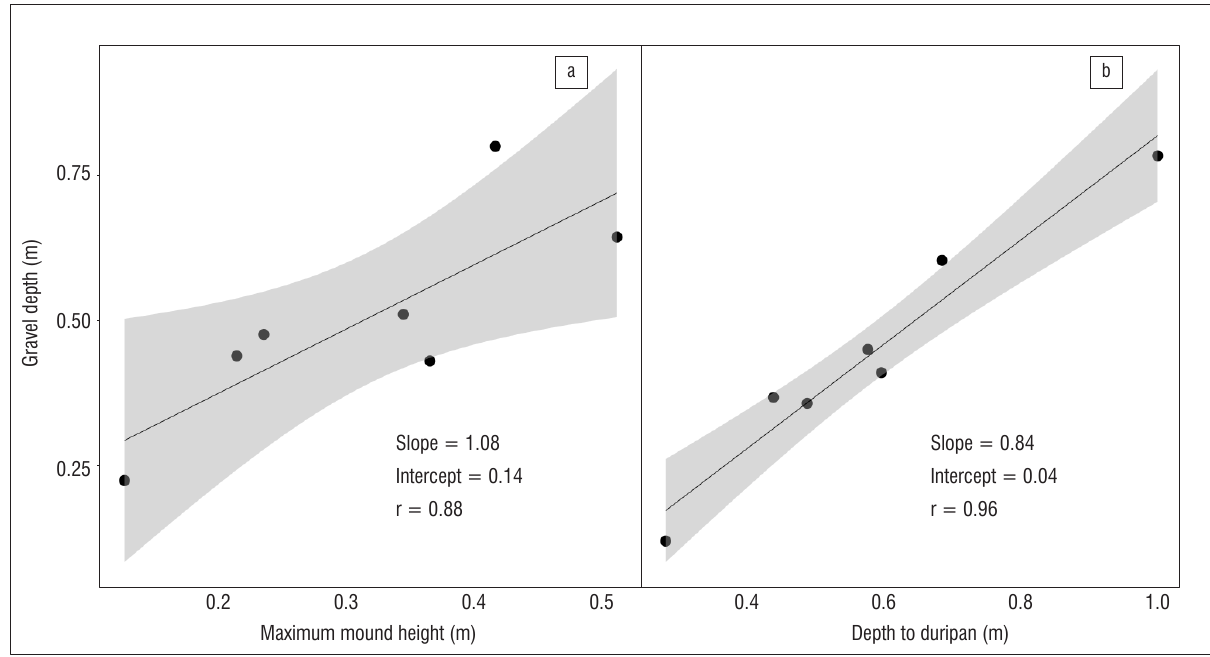
Figure 2: The depth below the mound surface of the maximum accumulation of gravel within each mound (assessed with an auger) was linearly related ( p <0.01) to the maximum height of the mounds above the surrounding landscape and to the depth to the duripan layer ( n =7). The grey band indicates the 95% confidence interval. The slopes, intercepts and Pearson correlation coefficients are